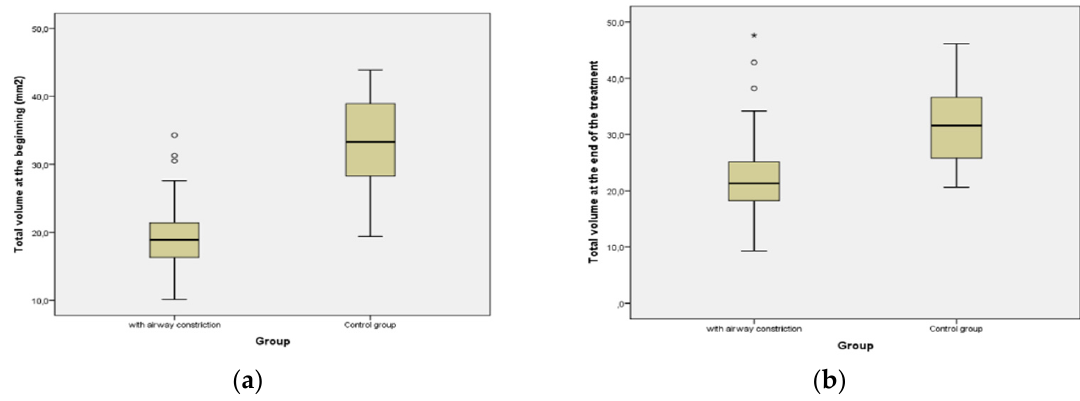
Figure 7. Comparison of volumetric changes of the airway before and after aligner treatment. ( a ) Pre-treatment; ( b ) post-treatment increase of airway volume in Group A and decrease in the control group.